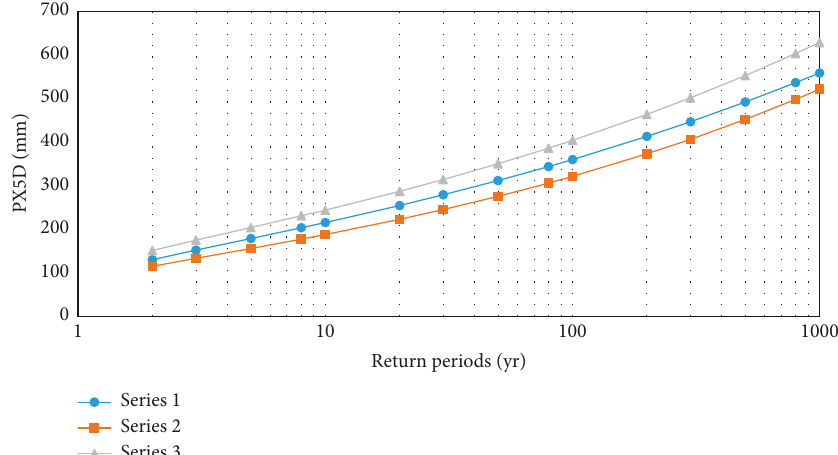
Figure 9: Frequency curves of the whole series (series 1), before (series 2), and after (series 3) the abrupt changes series of PX5D in Xihua